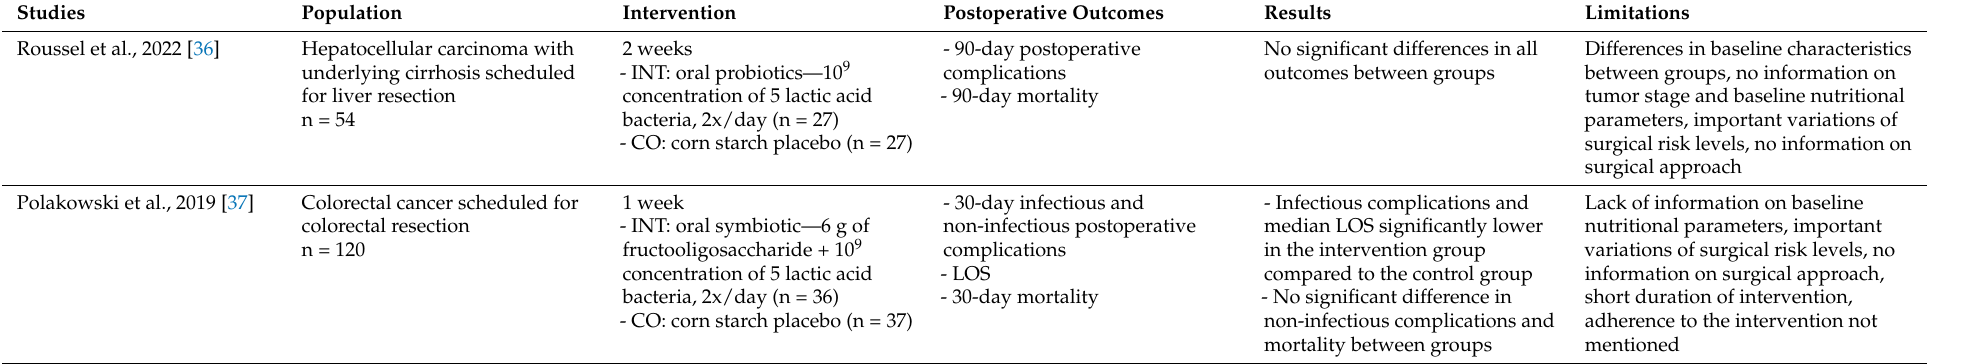
Table 3. Probiotics and symbiotics interventions before surgery in patients with gastrointestinal cancers.